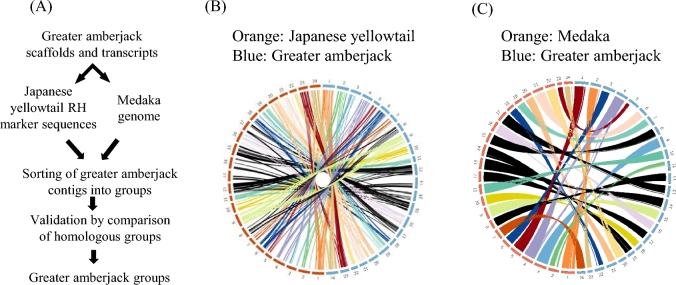
Overview of comparative mapping approach. (a) Workflow for the generation of in silico groups of the greater amberjack (Seriola dumerilii). (b) Circos illustration of mapping results between the greater amberjack (blue) and mapping results of transcripts to the Japanese yellowtail (orange).(c) Circos illustration of transcript mapping results between the greater amberjack (blue) and mapping results of transcripts to medaka (orange).